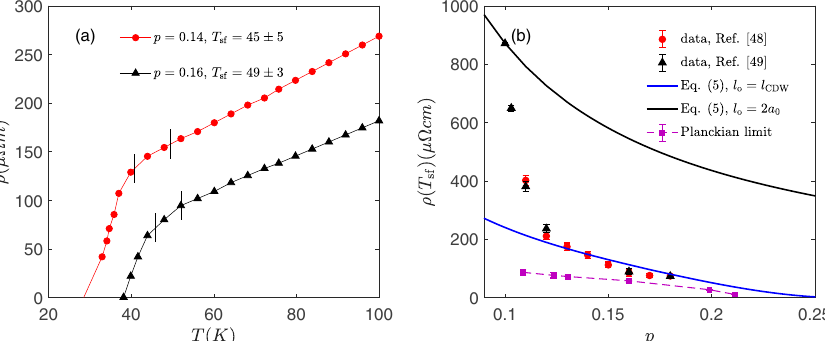
Fig. 4 Characteristic resistivity at the onset temperatures ( T sf ) of the SC fl uctuations in Bi-2201. a The temperature ( T ) dependence of the resistivity ( ρ ). The symbols represent the experimental data obtained by Ando et al. 48 . The pairs of vertical lines indicate the T sf error bars determined from the speci fi c-heat measurement 95 . b Doping ( p ) dependence of ρ ( T sf ). The red and black symbols represent the experimental values determined from previously reported measurements 48,49 . The vertical errors are estimated from the resistivity variation associated with the T sf error bars. The solid blue line represents Eq. (5) prediction with the scattering parameter γ (cid:2) Γ ¼ 0 : 11 and the charge density wave (CDW) period l CDW , which is compared to the prediction (solid black line) with the antiferromagnetism period length 2 a 0 , as well as the predictions (purple squares) from Planckian dissipation theory 50 with the effective mass m (cid:2) = 2.7 m e ( m e is the electron mass) and T fi t to data above p = 0.12 is 20 μ sf . The root mean squared error of the solid blue line